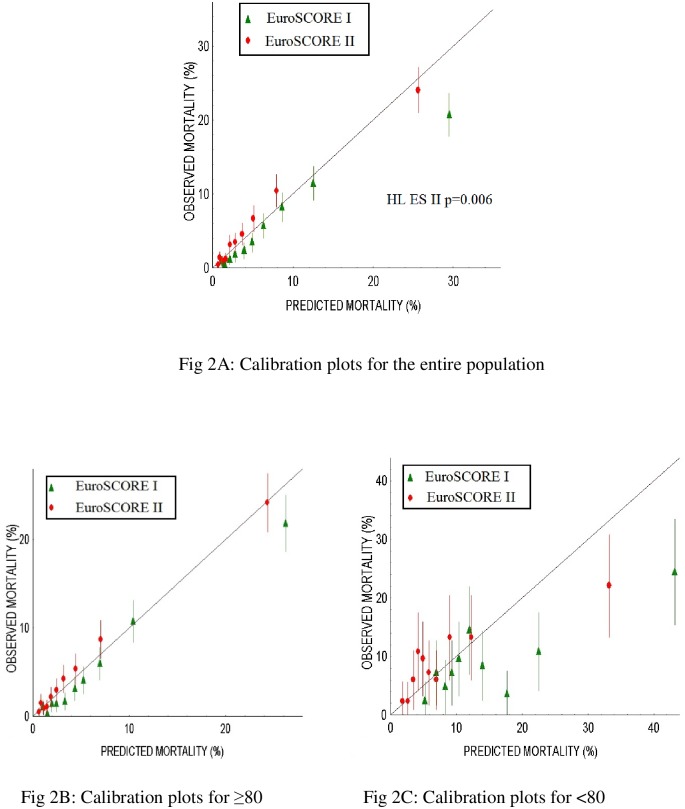
Calibration plots for the two models, for the entire population (Fig 2A) and the two studied groups (Fig 2B: ≥80 and Fig 2C: <80).